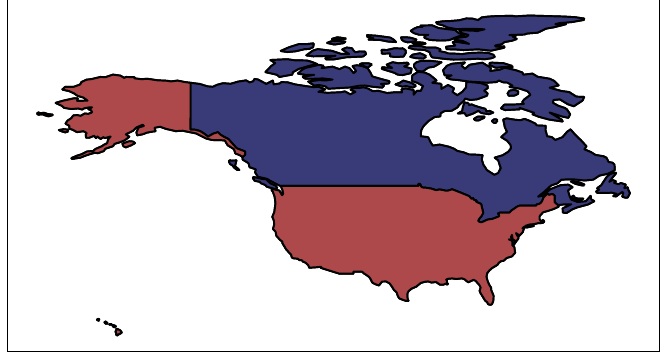
Figure 13. A map portraying the income groups of the most frequent collaborators of North American nations. Nations colored in blue most frequently collaborate with high-income group nations, nations in green most frequently collaborate with upper-middle-income group nations, nations colored in red most frequently collaborate with lower-middle-income group nations, and nations colored in white did not have publications in the data set.